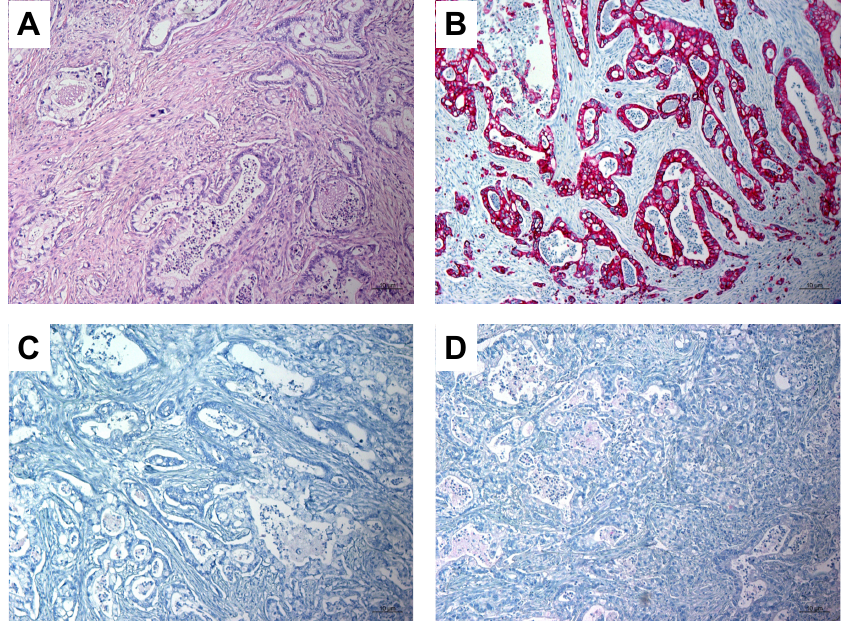
Figure 2. Histopathologic images showing pancreatic adenocarcinoma. ( A ): Hematoxilin-Eosin (H&E) stain, magnification 100×; ( B ): Immunohistochemistry: tumor cells show strong positive staining for CK7, magnification 100×; ( C ): Immunohistochemistry: tumor cells are negative for thyroglobulin, magnification 100×; ( D ): Immunohistochemistry: tumor cells are negative for TTF1, magnification 100×.